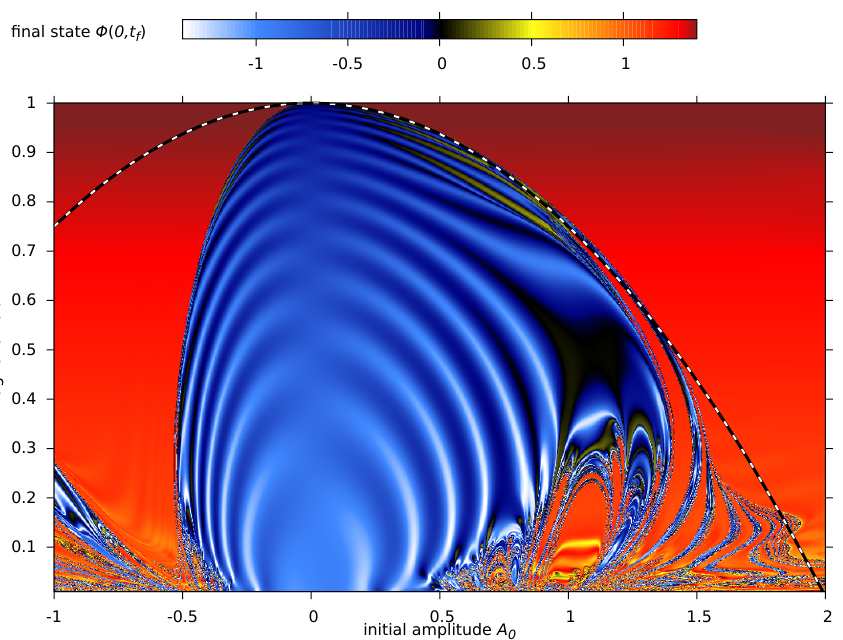
Figure 16 . The (cid:12)eld value on the boundary at time t f = 50 for initial conditions (cid:30) ( x; 0) = (cid:30) B ( x ) + A 0 (cid:17) B ( x ), (cid:30) t ( x; 0) = 0. The blue colour represents the region without kink creation. The dashed line corresponds to the function H = 1 (cid:0) A 2 = 4.